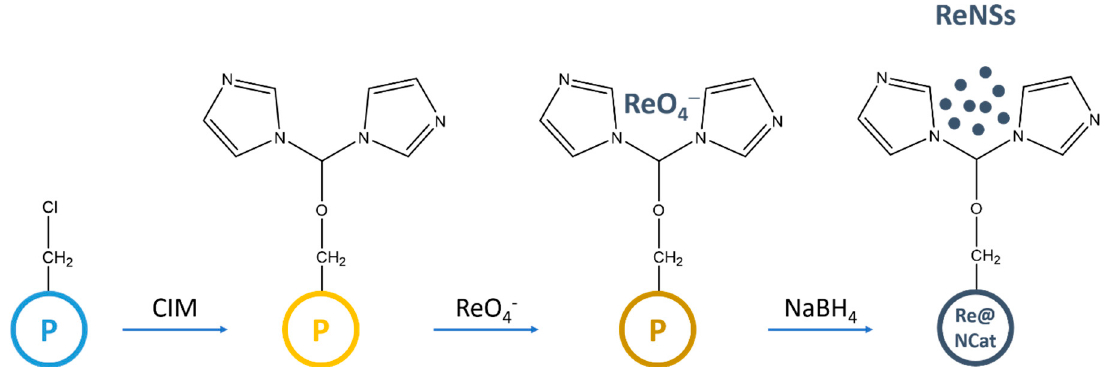
Figure 1. A simplified scheme of Re@NCat synthesis. The structure of the CIM functionality is proposed, based on the FT-IR analysis.